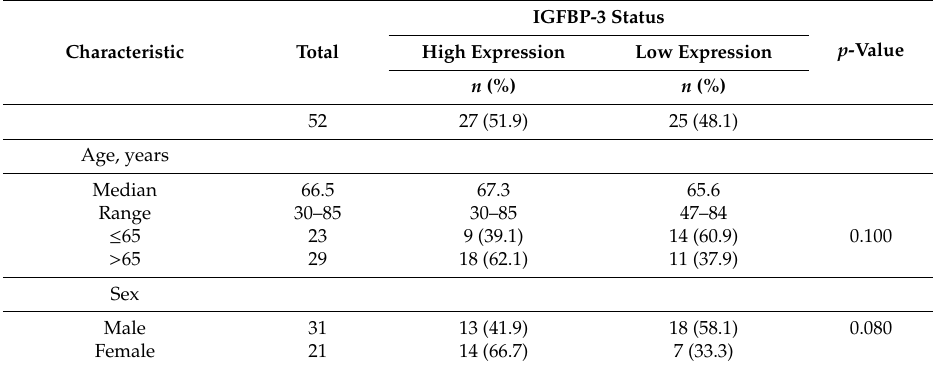
Figure 1. Tumour IGFBP-3 expression status a ff ects the survival of patients with oral squamous cell carcinoma (OSCC). ( A , B ) Immunohistochemical staining for IGFBP-3 in OSCC biopsy specimens. Representative microscopic images show the characteristic expression status ( A low expression; B high expression). Scale bar, 100 µ m. ( C , D ) Overall survival (OS) ( C ) and disease-free survival (DFS) ( D ) of patients with OSCC based on IGFBP-3 expression status. * p < 0.05. Table 1. Correlation between IGFBP-3 expression and clinicopathological factors in 52 patients with oral squamous cell carcinoma